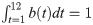
Time-related functions and variables used in the model.(A) The zebra birth function b(t) as defined by the monthly density of the annual number of births of plains zebra in the Kruger National Park (KNP) between August 1969 and March 1973. Solid grey lines show the adjusted birth data used to calculate b(t) and extracted from Smuts [17] who reported the temporal variation in the proportion of <1-month-old foals for two populations of KNP. Black solid line and grey envelop shows the birth function b(t) and its 95% confidence interval. Note that ∫t=112b(t)dt=1. (B) The activity function a(t) of Culicoides imicola as defined by the proportion of the maximum number of C. imicola per hosts per day recorded in each month in the Western Cape Province (WCP) and KNP. Data extracted from Venter et al [19]. Trap catch records from Stellenbosch and Eiland (see Fig 3A for location) were used to characterise midge activity in the WCP and KNP, respectively. (C) Daily variations in sunset temperature and variations of the annual rainfalls recorded in Stellenbosch (WCP) and Eiland (KNP).